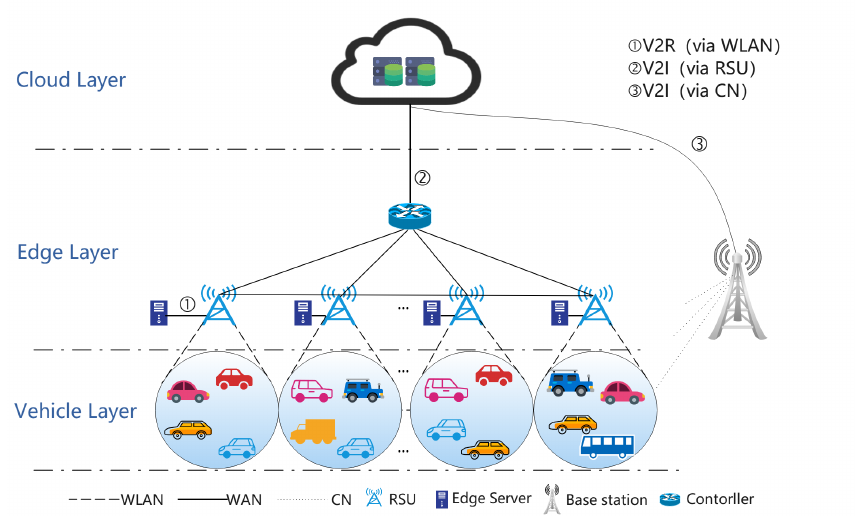
Figure 1. Multi-layered vehicular edge-computing